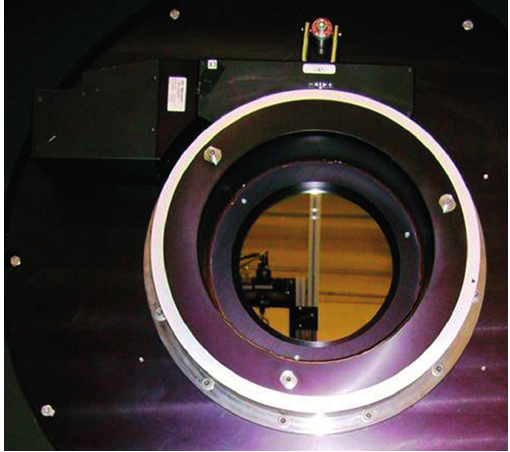
Figure 19. The sheet polarizer used to characterize the OLI polarization sensitivity.